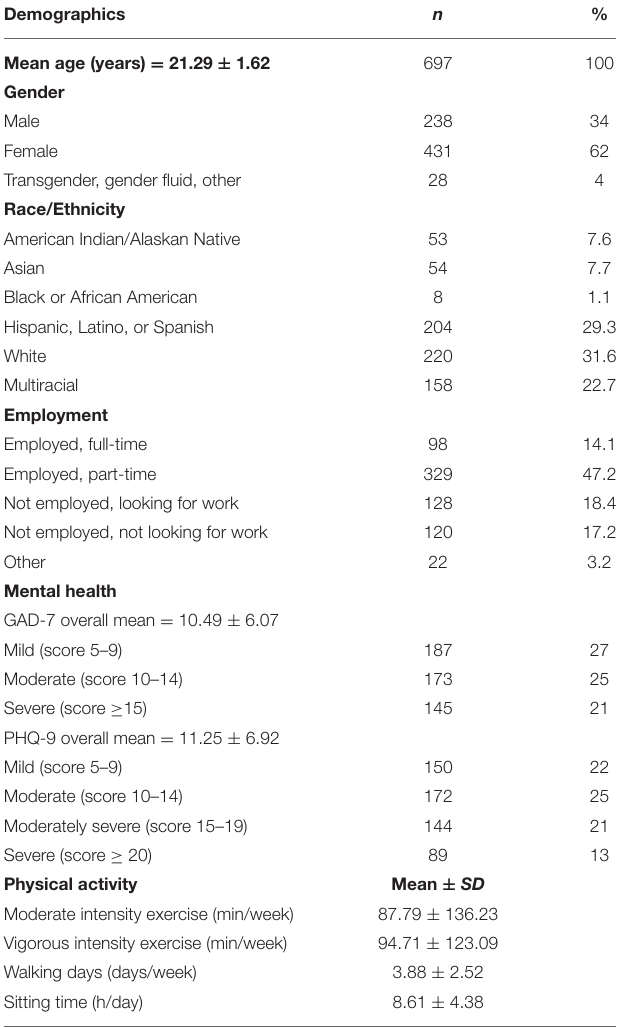
TABLE 1 | Demographic characteristics of study